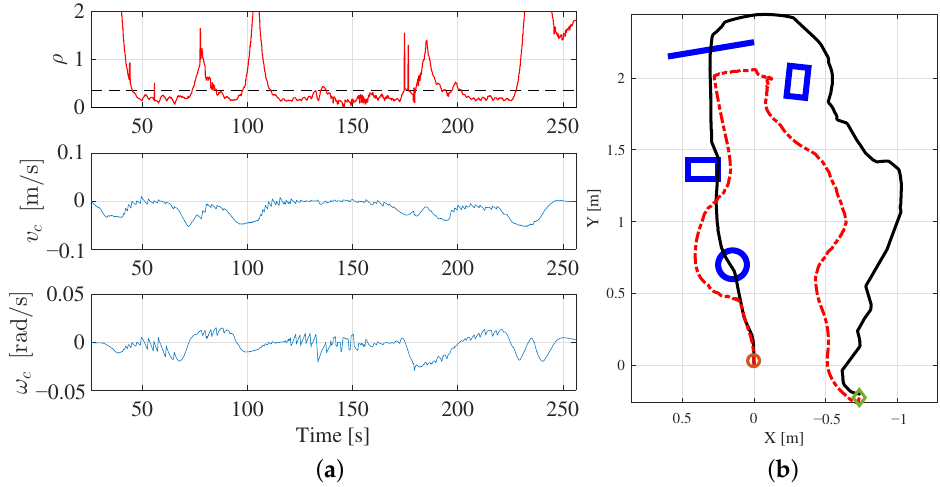
Figure 6. Case study 2: robot control performance. ( a ) Top graph: normalized distance ρ between the detected obstacles and the mobile robot boundary (the dashed line represents the distance threshold ρ 0 for the activation of the repulsive force). Middle and bottom graphs: linear and angular velocity commands for the mobile robot. ( b ) The 2D robot trajectory: starting robot position (small orange circle); ending robot position (small green diamond); robot trajectory (red dashed line); user reference trajectory (solid black line); and approximate location of the real obstacles (solid-thick blue lines).